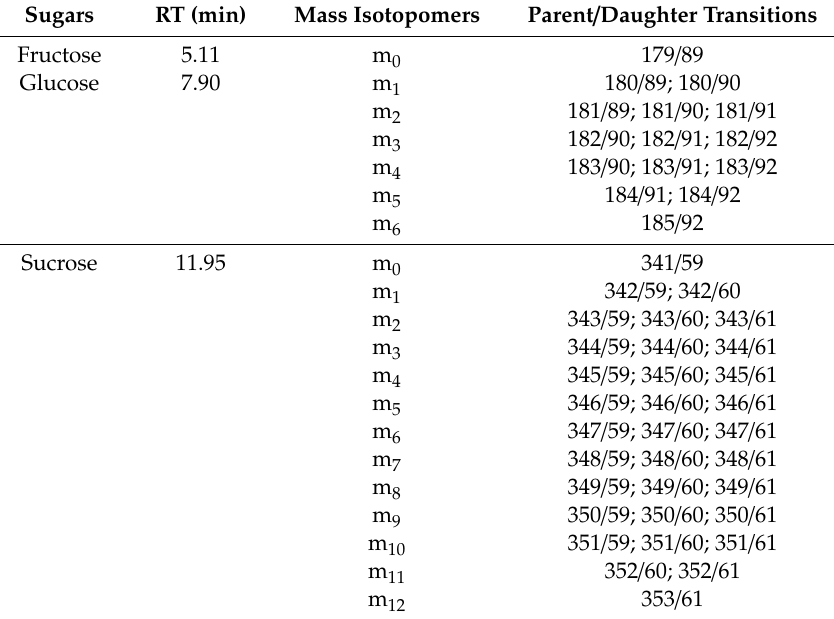
Table 2. 13 C-labeled sugar isotopomers using MRM. RT: Retention